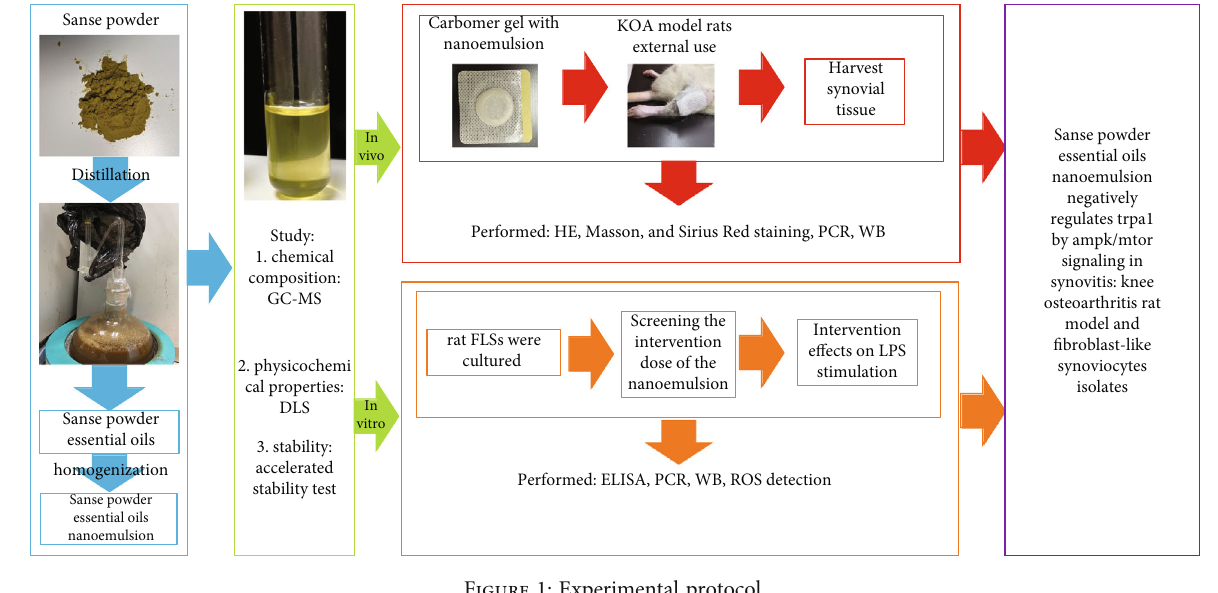
Figure 1: Experimental protocol. Table 1: Nucleotide sequences of